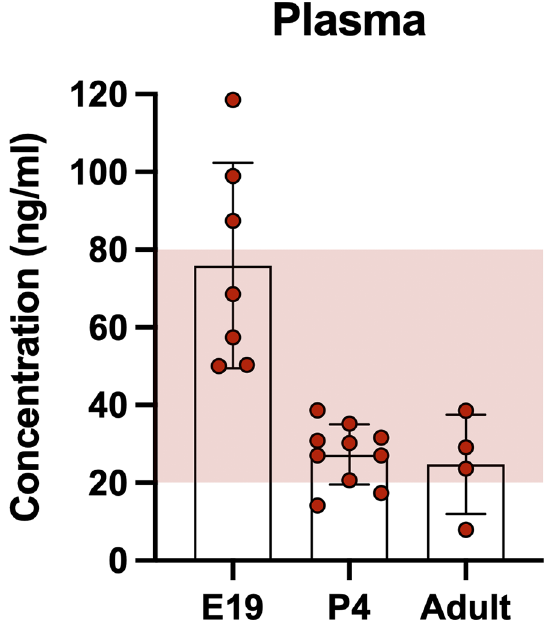
Figure 1. Concentration of olanzapine in rat plasma at three ages. At E19, P4 and adult 30 min after a singleintraperitonealinjectionof0.15mg/kgolanzapineitsconcentrationwasmeasuredusingliquidchromatography coupled withmassspectrometry (LC-MS). Shaded areaindicatesclinical therapeutic rangeof olanzapine(20 – 80ng/ml; Hiemke et al. 2011). Bars are means (cid:3) SD. Note each point is an individual animal (n=4 –